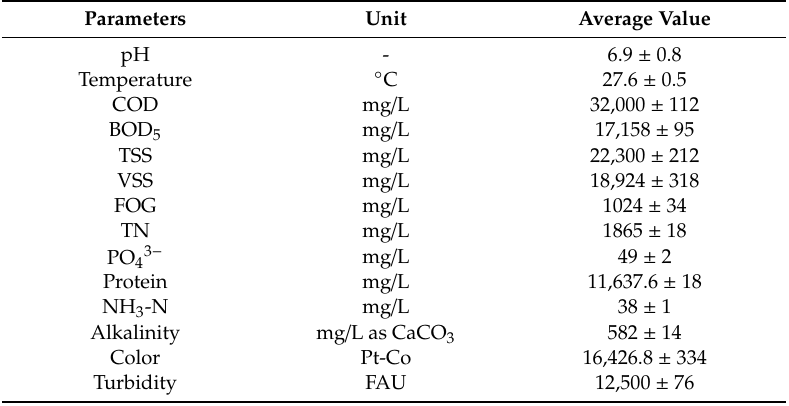
Table 1. Characteristics of the cattle slaughterhouse wastewater